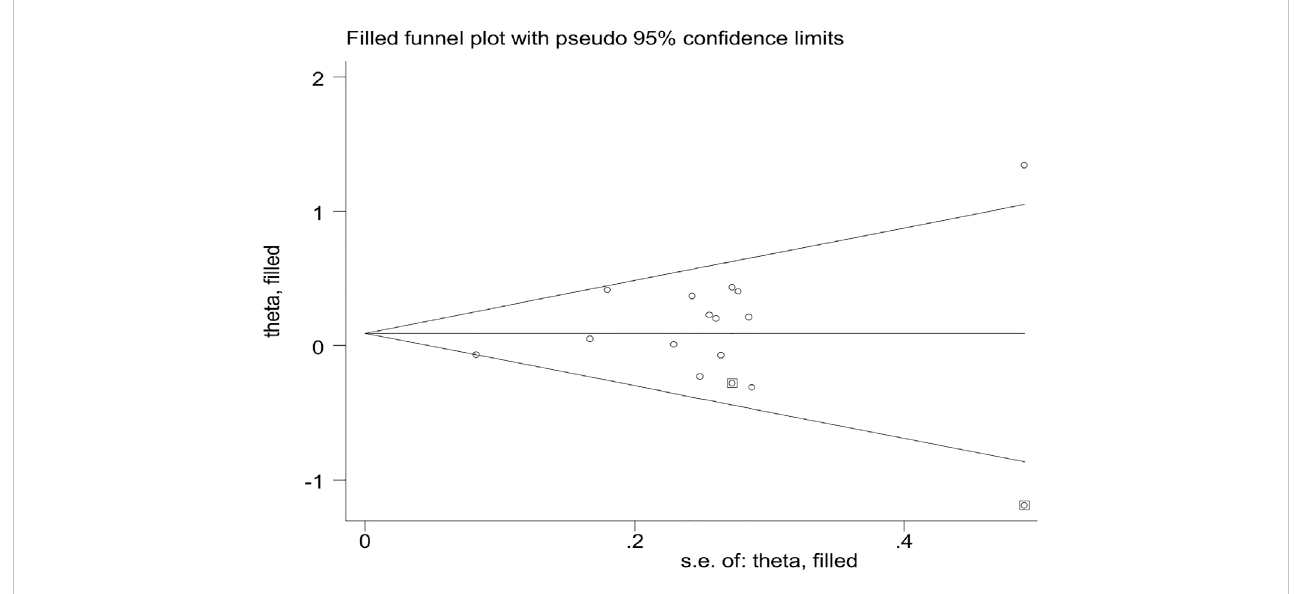
FIGURE 8 Publication bias assessed by funnel plot of GSTM1 present/null and ovarian cancer risk.